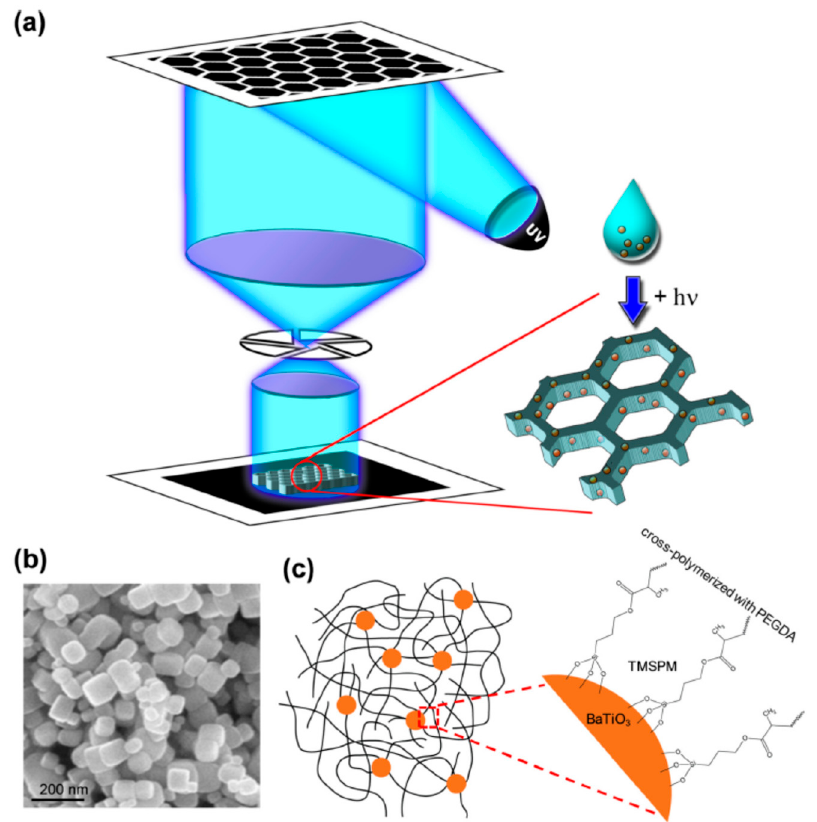
Figure 7. ( a ) Schematic of the DPP setup that projects dynamic digital masks on the photoliable piezoelectric nanoparticle–polymer composite solution. Any pattern can be digitized, and the digital mirror device projects the image onto the polymer solution. ( b ) A scanning electron micrograph of barium titanate (BTO) nanoparticles grown via a hydrothermal process. ( c ) A cartoon showing the piezoelectric polymer composite materials with BTO nanoparticles (orange circles) grafted to a polyethylene glycol diacrylate (PEGDA) matrix (black lines). The zoom-in shows the TMSPM linker covalently linked to the nanoparticle surface and cross-linked with the PEGDA matrix. Reprinted from [35], © 2014, with permission from American Chemical Society.